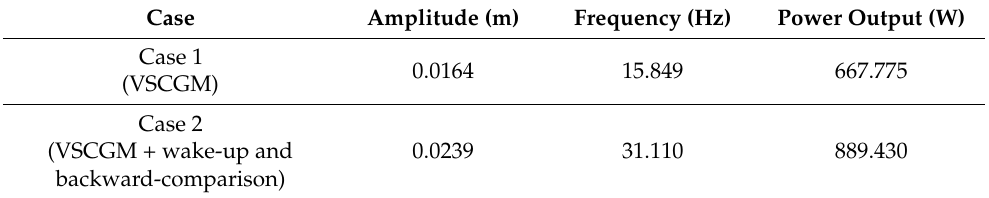
Table 5. Power output and oscillation parameters with the optimal designs for Cases 1 and